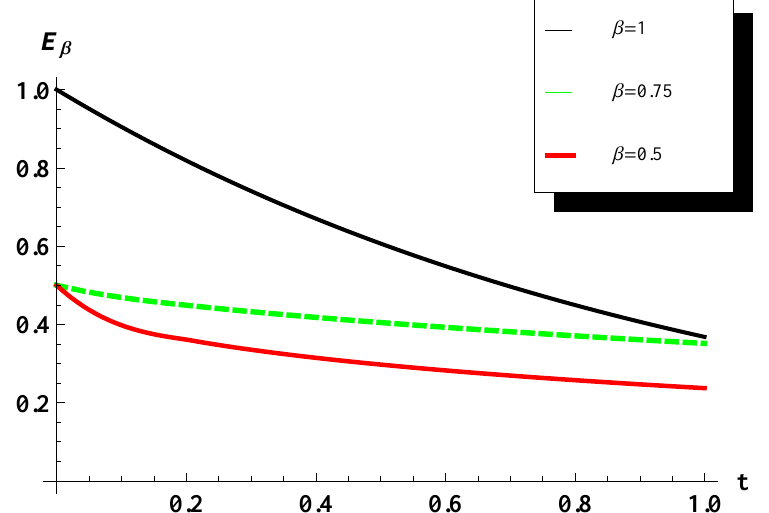
Figure 1. The simulation of the Mittag–Leffler as t : 0 → 1, for different values of β .